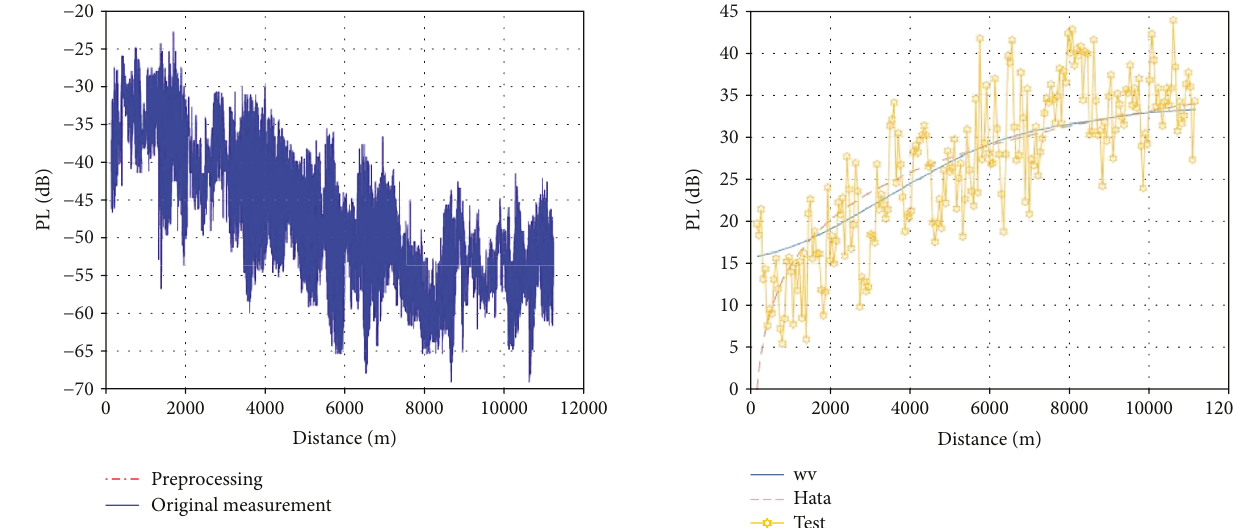
Figure 2: The test data and the interpolated data.